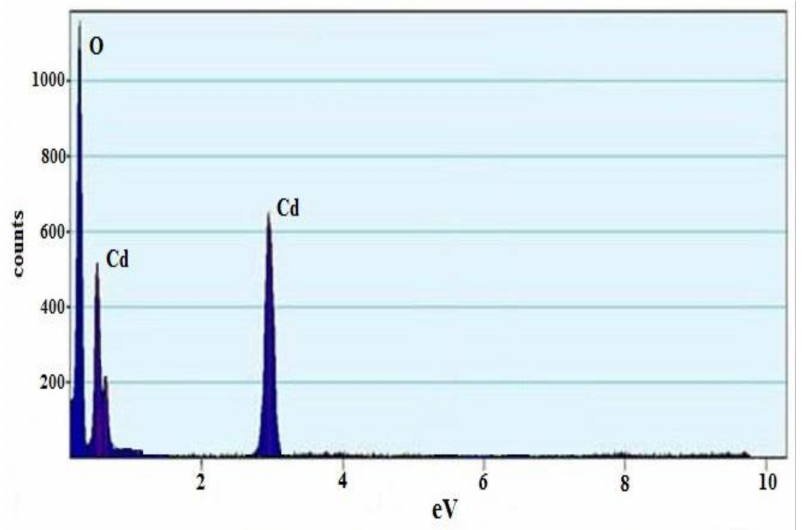
Figure 8. EDX of the as-prepared CdO nanoparticles.